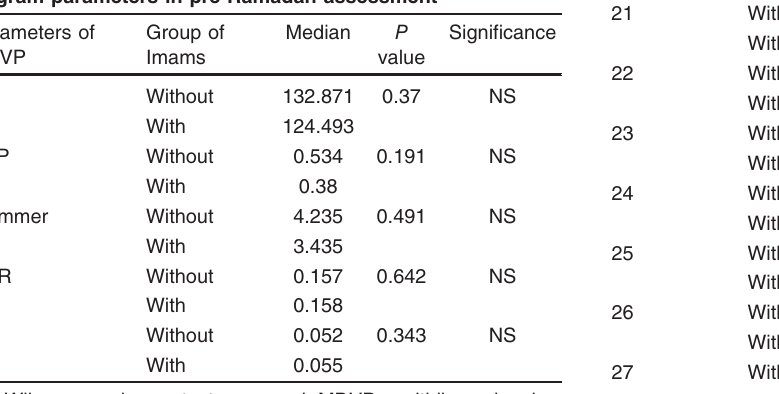
Table 2 Comparison between the results of the first group (those who received voice hygiene advices with) and the control group according to the multidimensional voice program parameters in pre-Ramadan assessment Parameters of MDVP